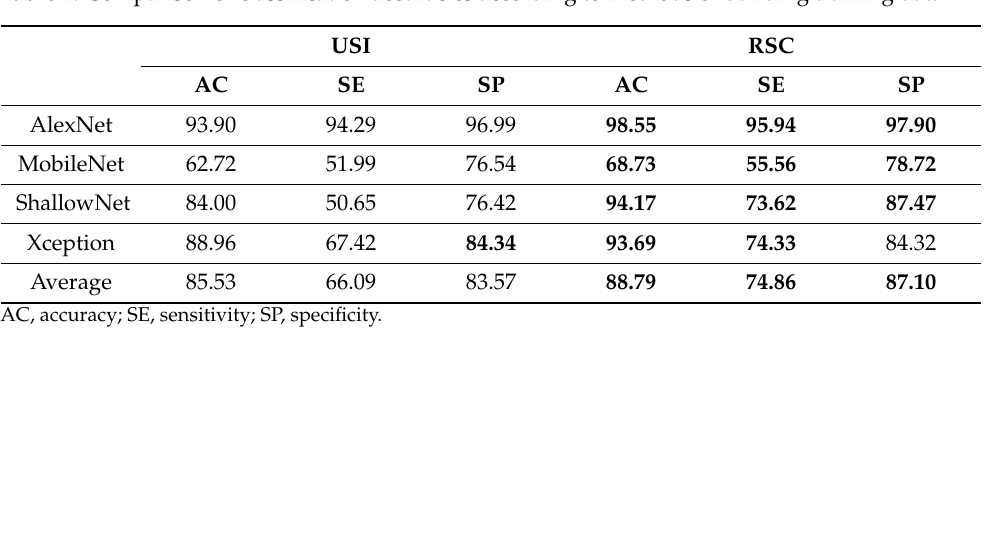
Table 2. Comparison of classification accuracies according to methods of building training